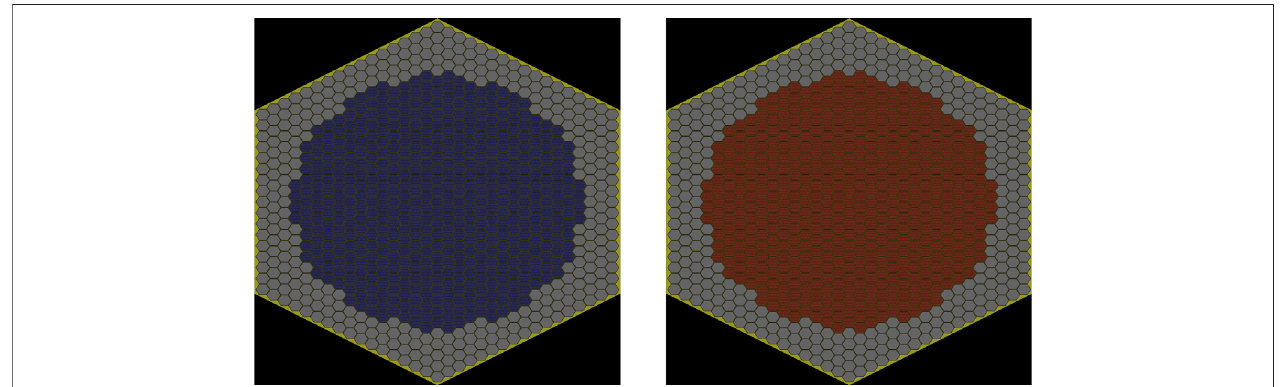
FIGURE 8 | The uniform models to tally the database fi ssion matrices.